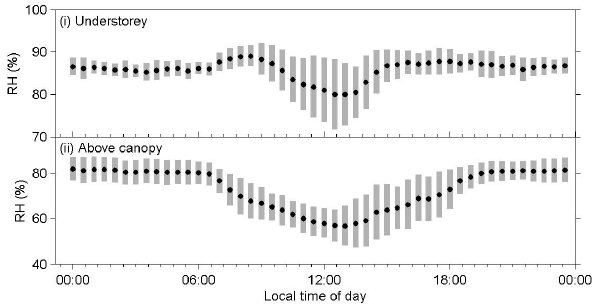
Fig. 2. Diurnal mean air temperature (i) in the understorey and (ii) above canopy in June–July 2008. Circles represent mean tempera- ture and boxes represent ± 1standard deviation.